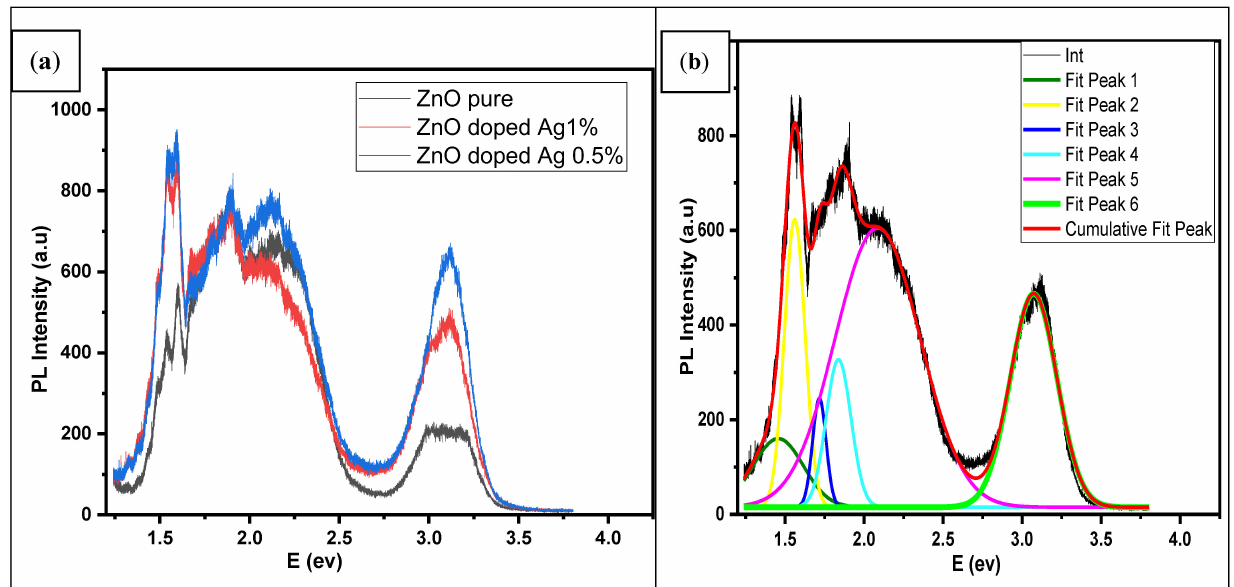
Figure 5. ( a ) Room temperature PL spectra of pure ZnO and Ag-doped ZnO 1%, 0.5% mol thin films, and ( b ) Gaussian deconvolution of Ag-doped ZnO thin